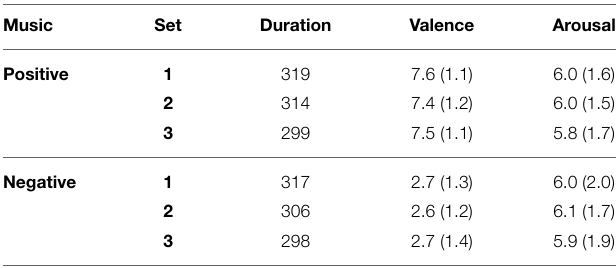
TABLE 1 | Means (with SDs) of music specifications for Positive and Negative mood conditions. Music